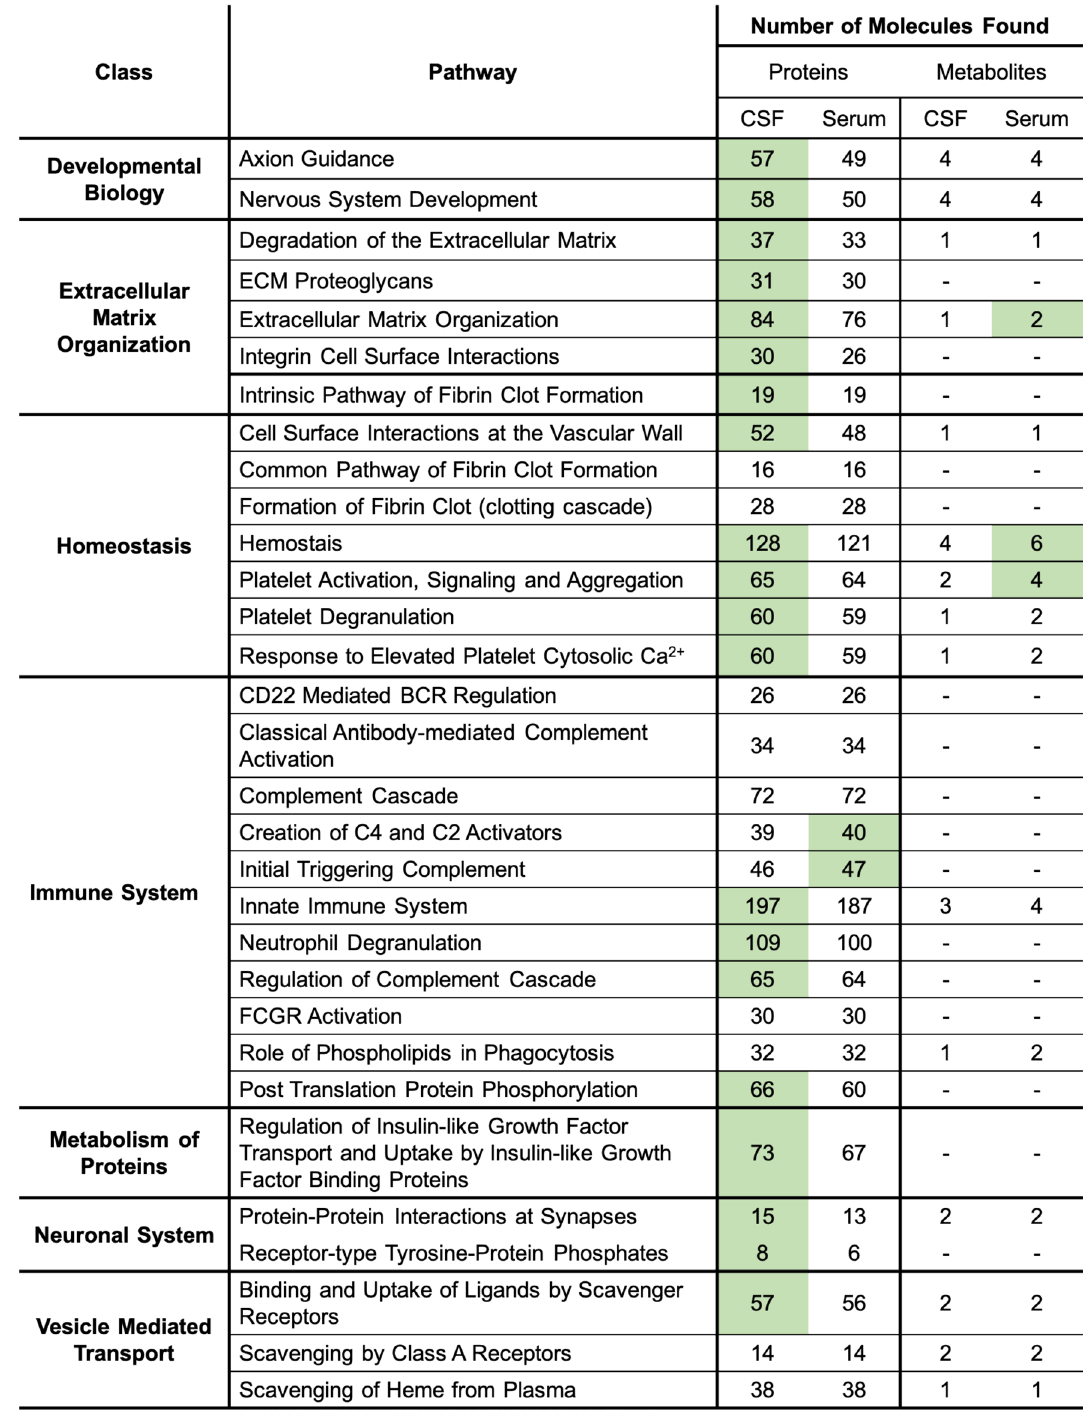
Table 1. Over-representation analysis of intersecting pathways between the proteome and metabolome of CSF and serum from Reactome. The general class of pathways (left), pathways found (middle), and the number of either proteins or metabolites found associated with each (right). The media (CSF or serum) with a higher number of identified molecules was highlighted in